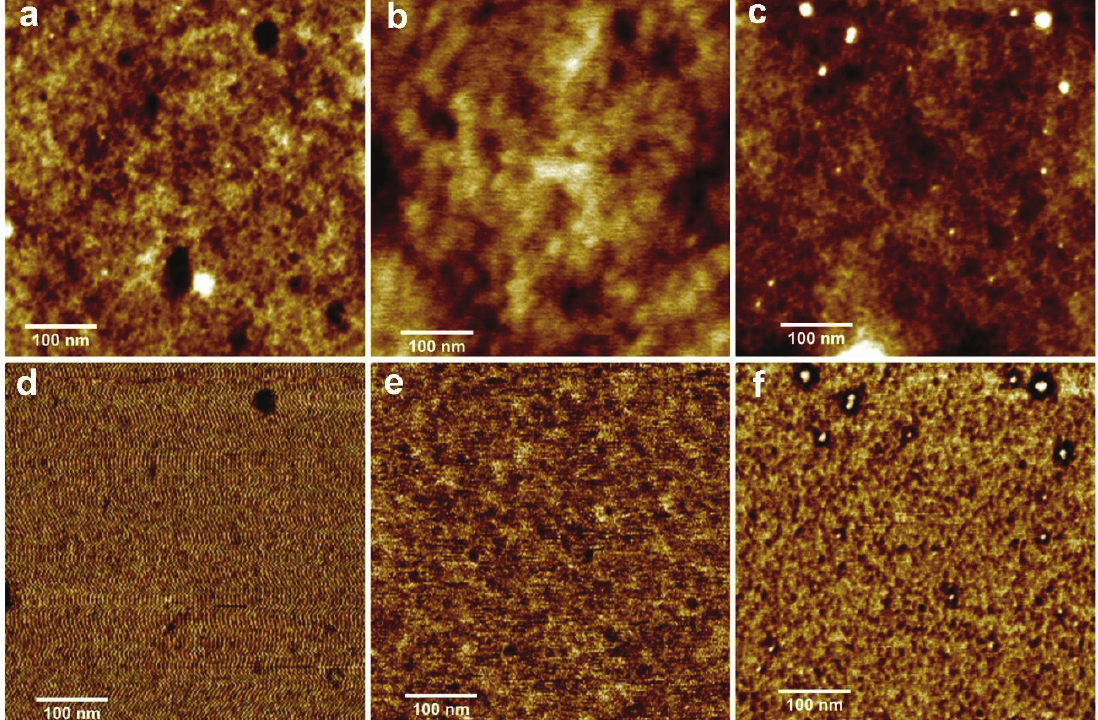
Figure 5: AFM height (a-c) and phase (d-f) of as-casted film (a,d), after DIA (b,e) and after acid vapor treatment followed by washing (c,f) for Polymer